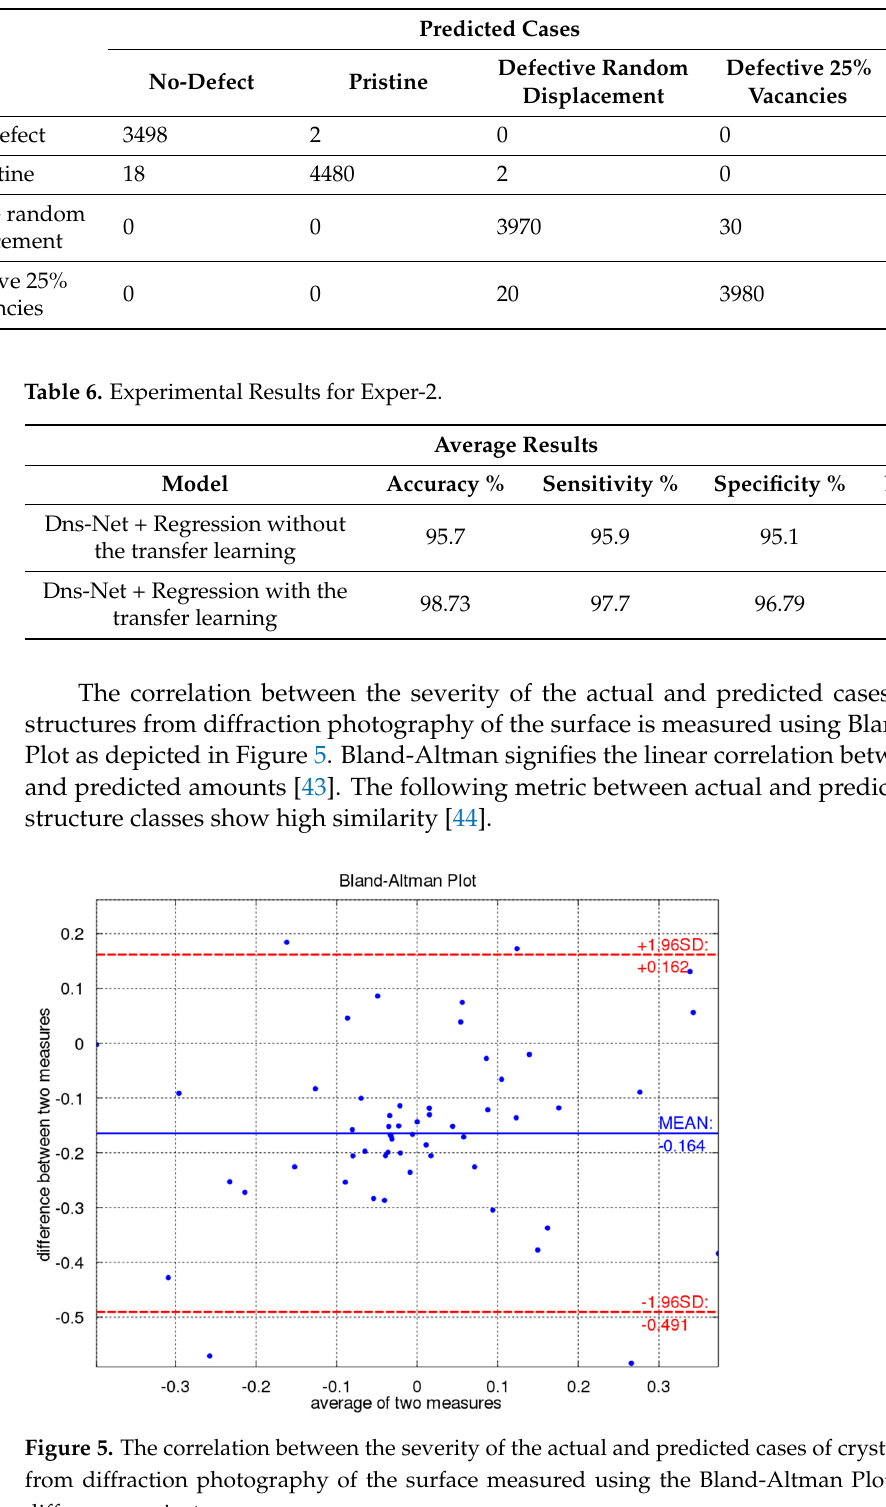
Table 5. Exper-2 confusion matrix for Dns-Net + regression with transfer learning. Table 5. Exper ‐ 2 confusion matrix for Dns ‐ Net + regression with transfer learning.